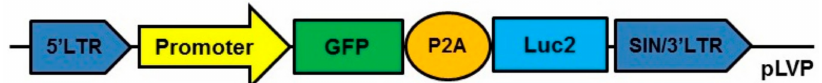
Figure 5. Scheme of the lentiviral constructs used for in vivo experiments. Promoter pCMV or pPCNA. GFP: green fluorescent protein ( EGFP ) gene used as reporter gene. Luc2: firefly luciferase 2 gene. P2A: the DNA sequence of P2A peptide of the porcine